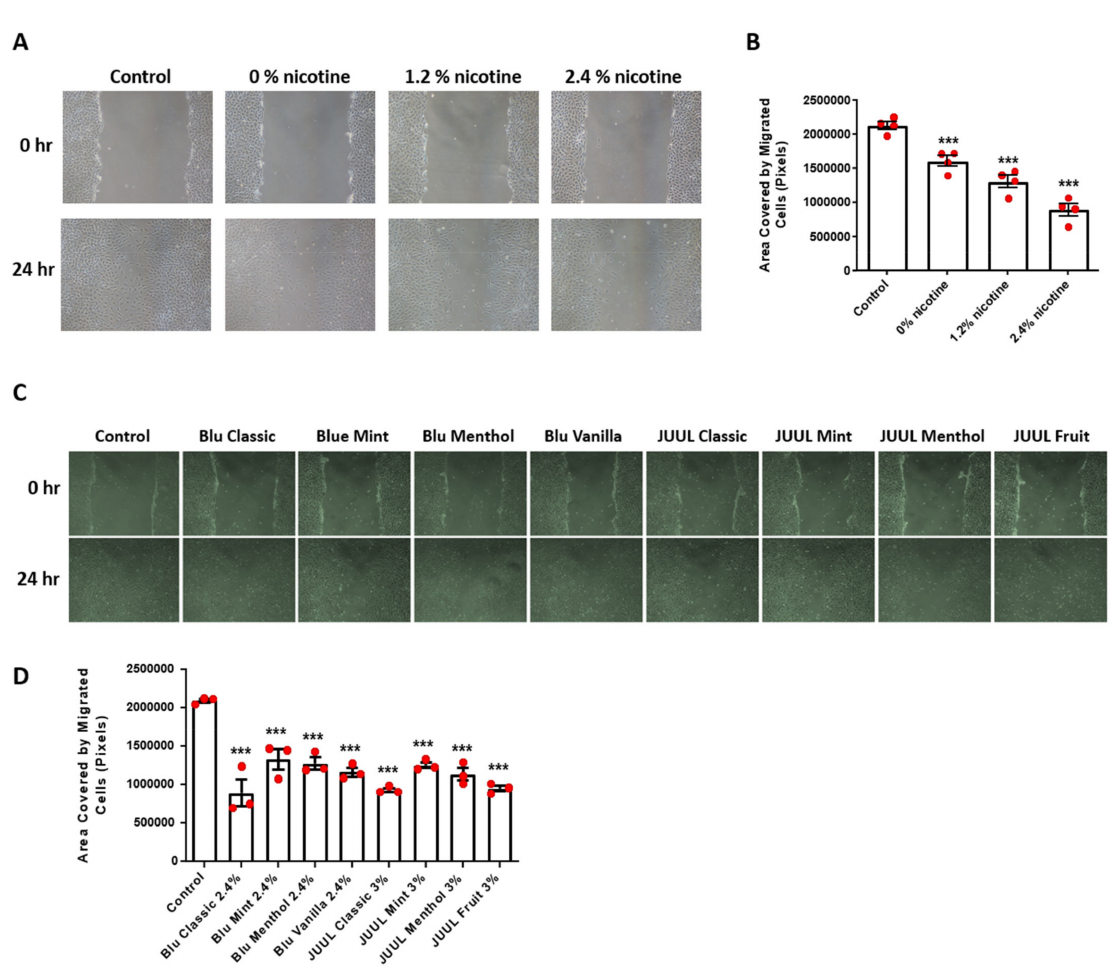
Figure 4. Nicotine containing and flavored e-cigarettes induce impaire endothelial cell wound healing in vitro. Confluent endothelial cells were starved overnight before a 1-mm wound was created using a P1000 tip. The wounded area was labeled and imaged as 0 h, and then exposed to e-CSE. The same area of the wound was imaged again after 24 h. Sizes of the wound areas were analyzed by NIH ImageJ software and presented as area covered by migrated cells (area at 0 h–area at 24 h). ( A ) Representative endothelial monolayer wounds before and after treatment with e-CSEs prepared from e-cigarettes containing different levels of nicotine (Gold leaf [Blu], at nicotine levels of 0%, 1.2%, and 2.4%). ( B ) Grouped wound healing data demonstrating reduced endothelial wound closure